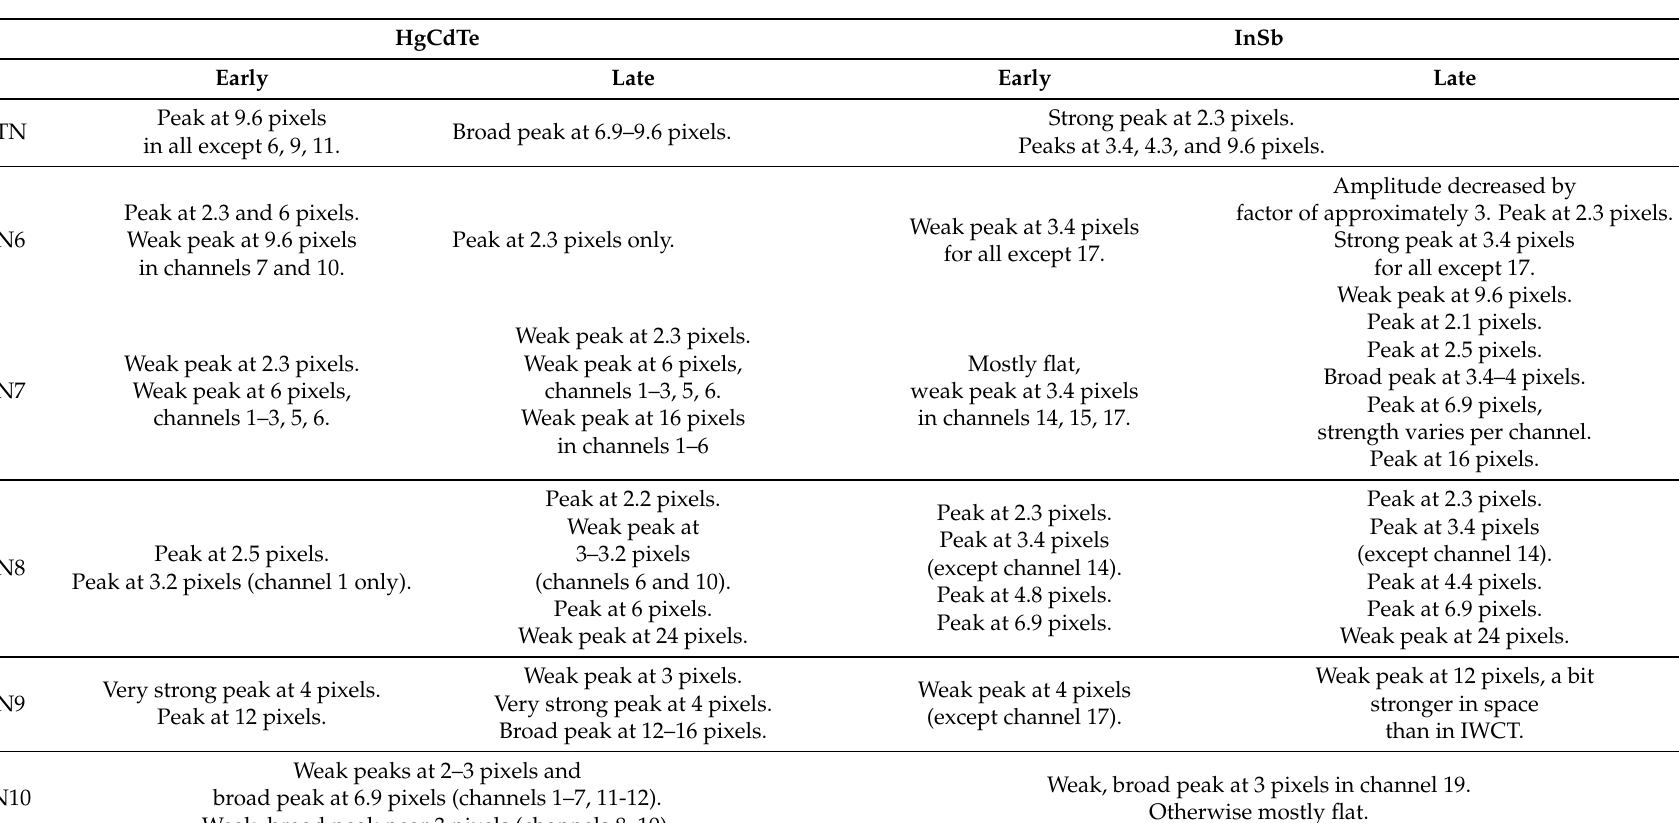
Table 3. Summary of notable features in calibration power spectra as shown by the red and teal lines in Figure 9 and similar figures (not shown), for HIRS/2 and HIRS/3 1